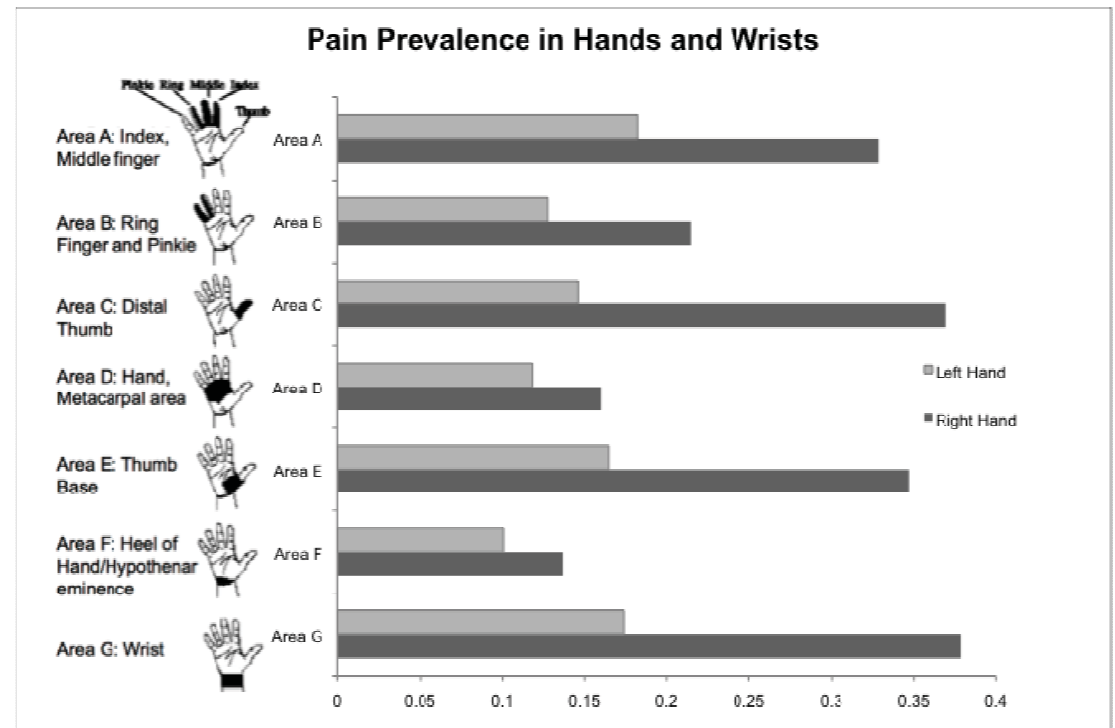
Figure 1. Percentage of participants experiencing MSD of any region of the hands and wrists in the past month of spay-neuter work (Hand images used with permission of the Human Factors and Ergonomics Laboratory at Cornell